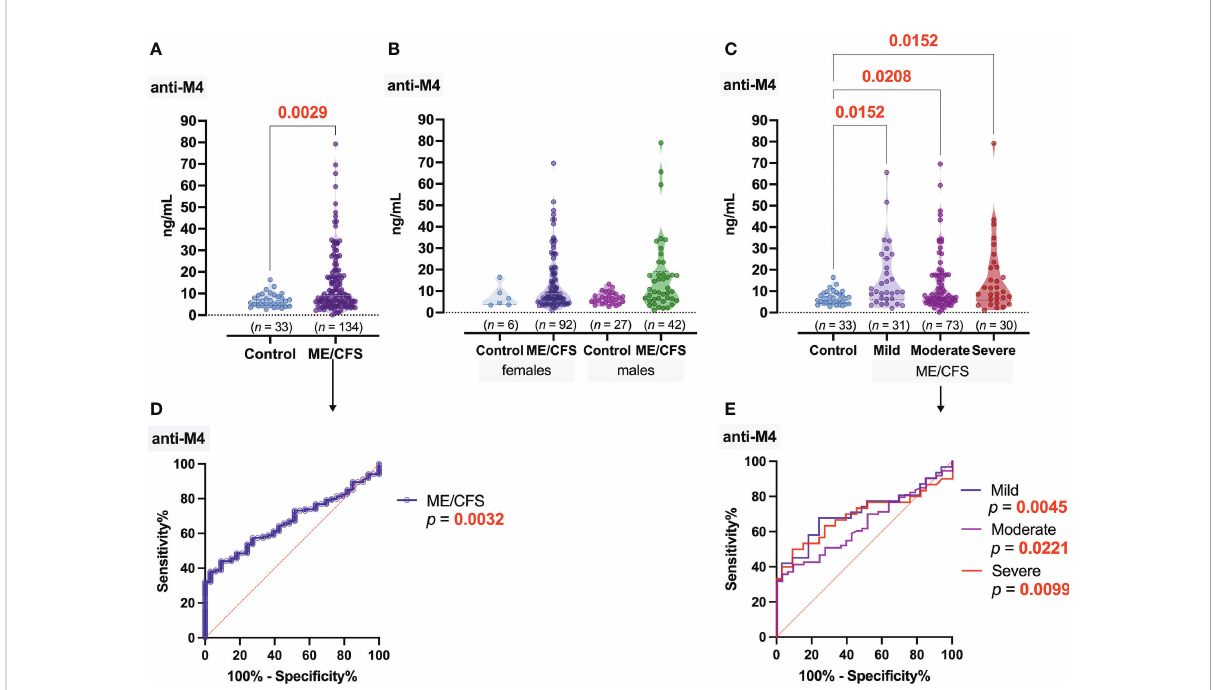
FIGURE 3 Concentration of antibodies to muscarinic cholinergic receptor 4 (anti-M4): (A) Healthy control (donors) and ME/CFS patients. (B) Regarding women and men of both groups. (C) Regarding ME/CFS severity; numbers above graphs show p -value, determined by Mann – Whitney test (A) or Kruskal – Wallis test with respective post-test (B, C) . (D, E) ROC analysis showing the potential of anti-M4 as a discriminating marker for